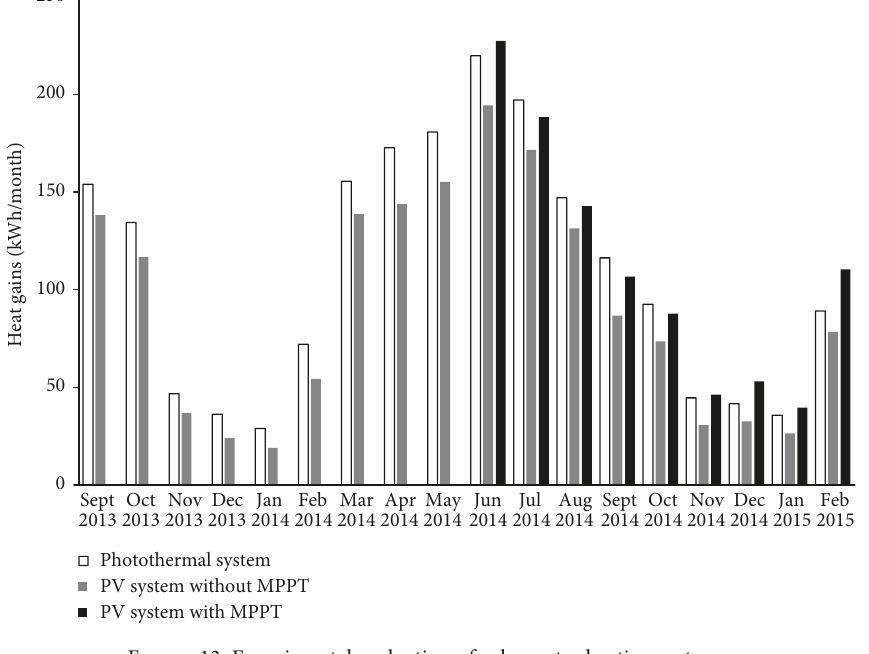
Figure 13: Experimental evaluation of solar water heating systems.